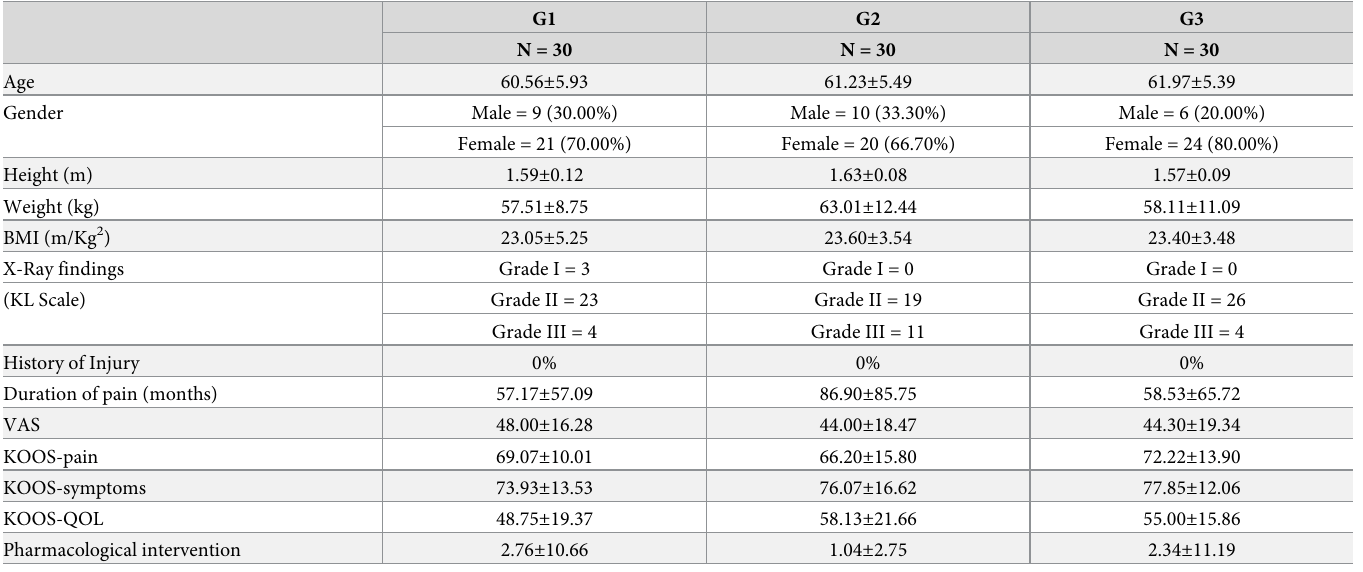
Table 1. Characteristics of